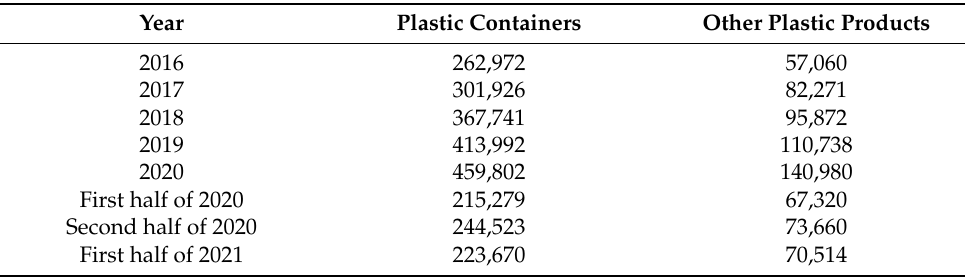
Table 3. Reported amounts of plastic containers and other plastic products recycled by implementing agencies in Taiwan since 2016 1